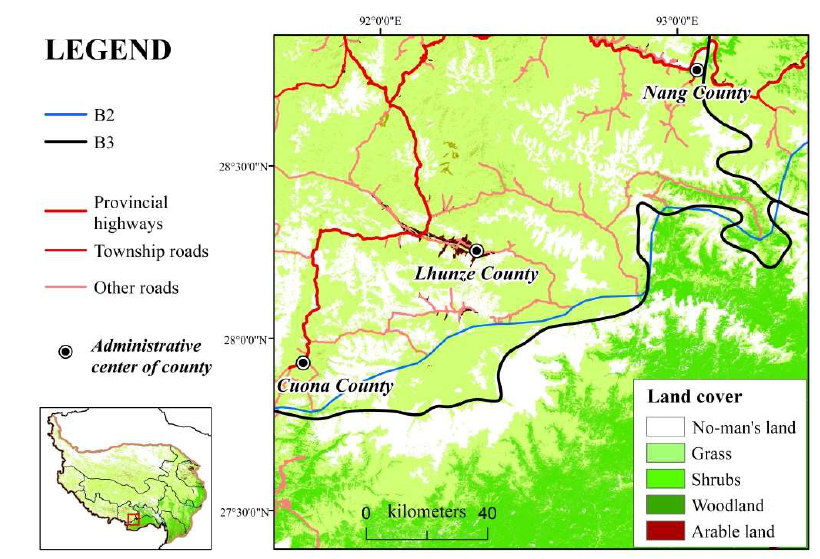
Figure 5. Example Area with B2 and B3. (In the southern part of Lhunze, Cuona, and Nang Counties, the breakpoint line of the lowest-grade roads (B2) is amended by the boundary of no-man’s land